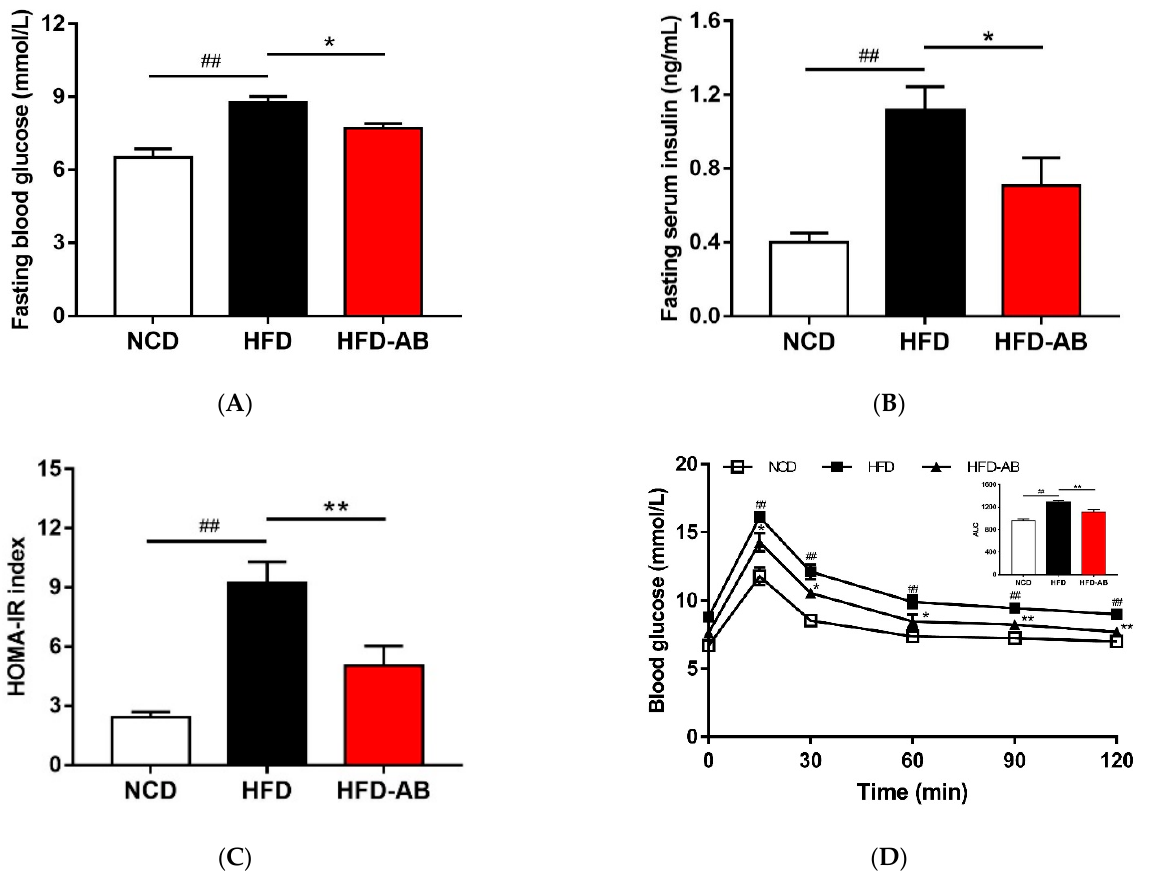
Figure 4. Adzuki bean supplementation improved glucose homeostasis. ( A ) Fasting blood glucose level, ( B ) fasting serum insulin level, ( C ) HOMA-IR index, and ( D ) glucose levels during the oral glucose tolerance test (OGTT). Data are shown as mean ± SEM, n = 7–8 per group. ## p < 0.01, HFD compared with NCD mice. * p < 0.05 and ** p < 0.01, HFD-AB compared with HFD mice. NCD, normal control diet; HFD, high-fat diet; HFD-AB, high-fat diet supplemented with adzuki bean.